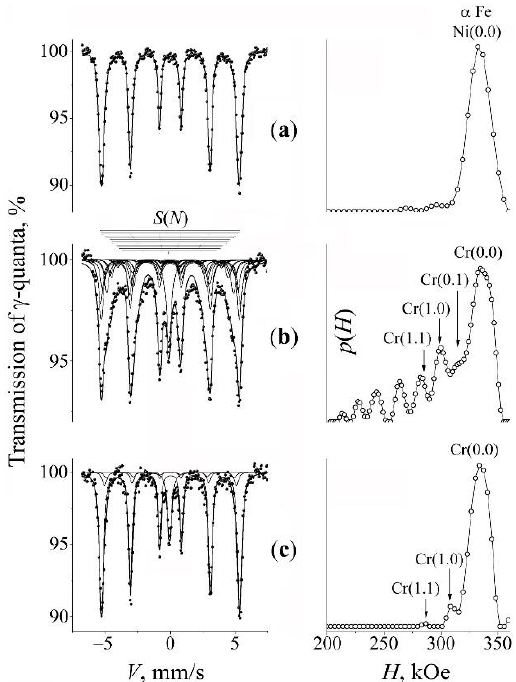
Figure 3. Mössbauer spectra of the mixture “ C ” (Fe – 6Ni + CrN) and the distributions p ( H ) for the α -phase. Treatment: ( a ) — initial mixture; ( b ) — PBM, 10 h; ( c ) — PBM, 10 h + anneal 650 °C, 1 h. The arrows at the distribution p ( H ) mark the peaks corresponding to occupations by the impurity atoms Cr in the first two CSs of iron.